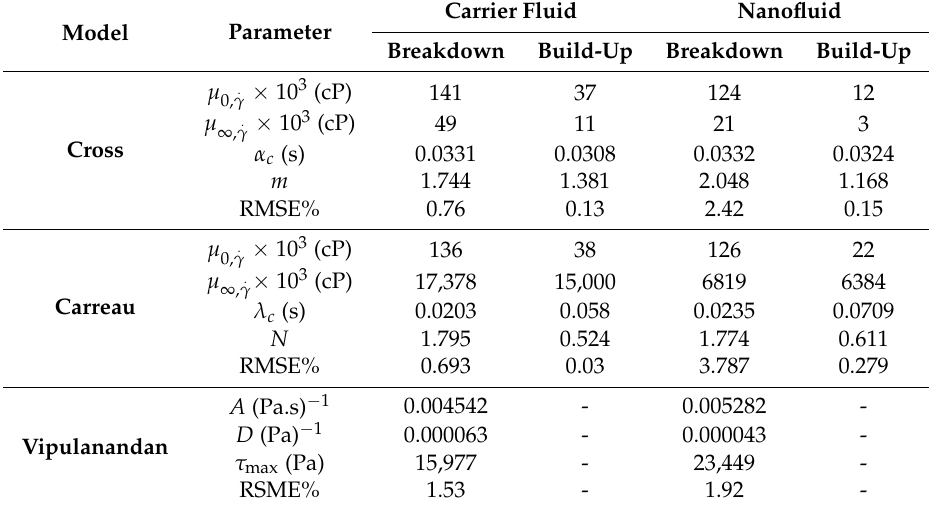
Figure 8. Shear stress curve from the breakdown flow curves of the hysteresis loop tests at 30 °C for an extra ‐ heavy oil (EHO) in the presence of 5 vol % of ( a ) the carrier fluid composed of a xylene/dimethylformamide ratio of 0.2, and ( b ) the nanofluid with S9 nanoparticles at 1000 mg ∙ L − 1 composed by the carrier fluid. The symbols are experimental data, and the continuous lines are from the Vipulanandan model. Table 5. Cross, Carreau and Vipulanandan models parameters for the hysteresis behavior at 30 ◦ C of extra-heavy oil in the presence of 5 vol % of the carrier fluid composed of a xylene/dimethylformamide ratio of 0.2 and the nanofluid with S9 nanoparticles at 1000 mg · L − 1 suspended in the carrier fluid.